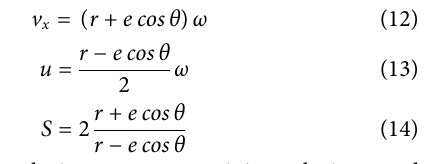
FIGURE 7 | Sliding velocity Δ u (cid:3) v x and entraining velocity u devided by the rotational speed of the cam, and slide-to-roll ratio S . Spline engine